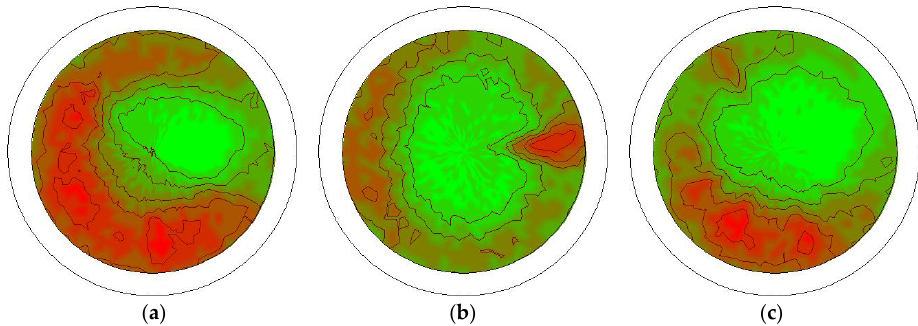
Figure 4. XRD pole figures (in stereographic projection) at 2θ = 30.5° of the {111} lattice planes of the fcc (A1) structure. ( a ) Al 0.2 CoCrFeNiTi; ( b ) Al 0.8 CoCrFeNiTi; ( c ) Al 1.5 CoCrFeNiTi.